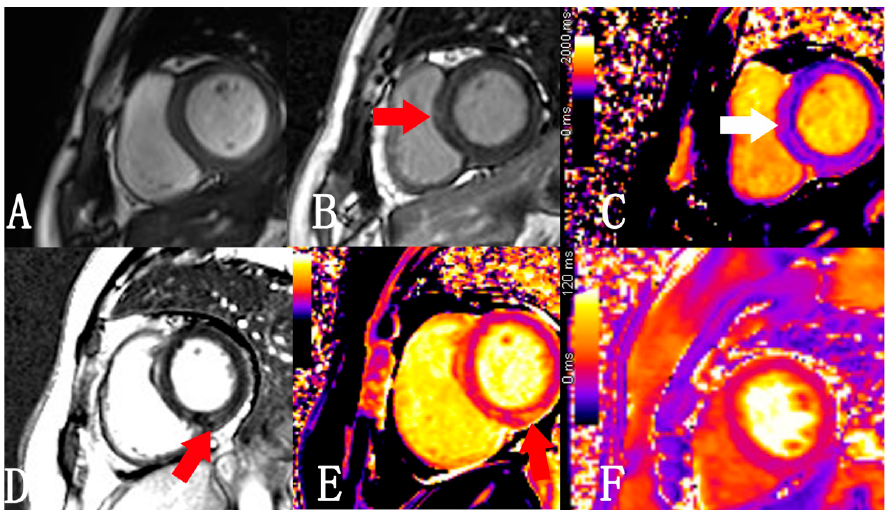
Figure 2. ( A – C ) A 61-year-old man with multiple myeloma who had undergone 4 cycles of chemo- therapy within 5 months (bortezomib 2.25 mg, lenalidomide 25 mg, and dexamethasone 40 mg). ( A )